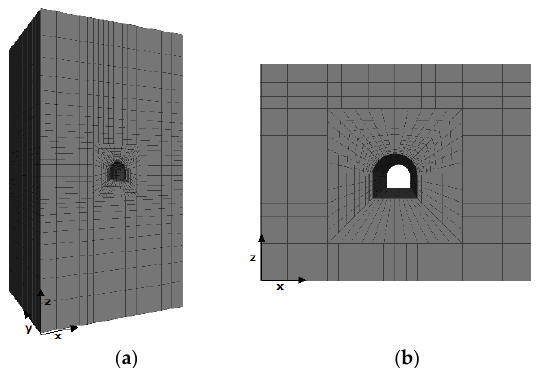
perspective; ( b ) plan view of the xyz xz